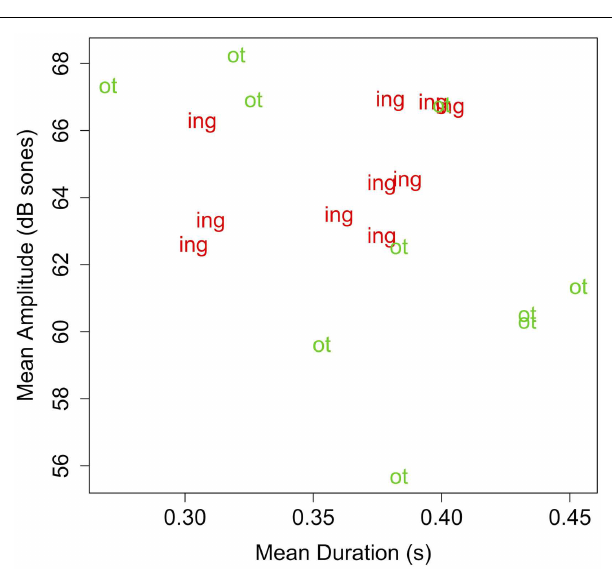
FIGURE 1 | Plot of duration (s) by amplitude (dB sones) for suffixes in Experiment 1. Each data point represents the mean of the duration and amplitude of the affix, averaged across the three tokens of a familiarization